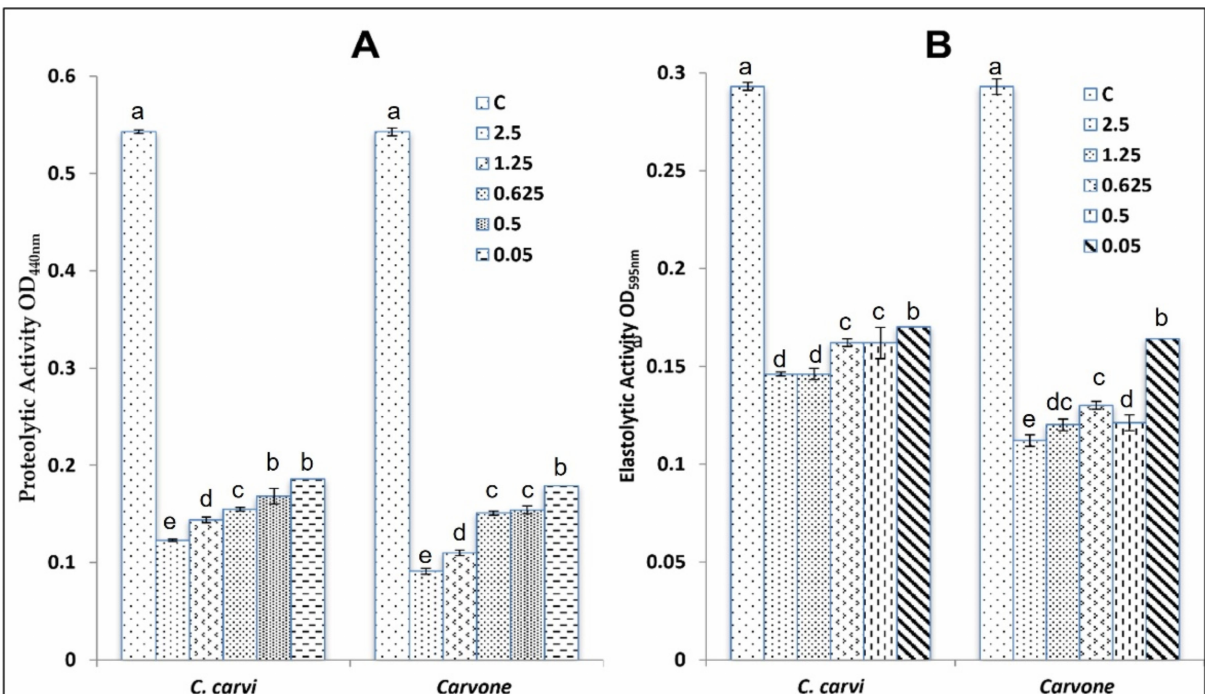
Figure 3. Effect of caraway essential oil and its main compound (Carvone) tested at different concentrations on P. aeruginosa PAO1 (virulence-related properties controlled by quorum-sensing system: ( A ) proteolytic activity; ( B ) elastolytic activity). Values are the average of at least three independent determinations. Means followed by the same letters are not significantly different at p < 0.05 based on Duncan’s multiple range test.